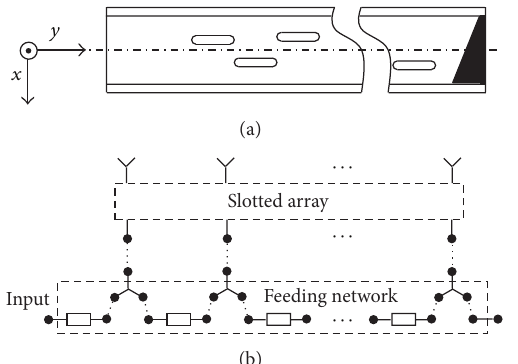
Figure 13: The traveling wave array. (a) Configuration. (b) Equiva- lent circuit.